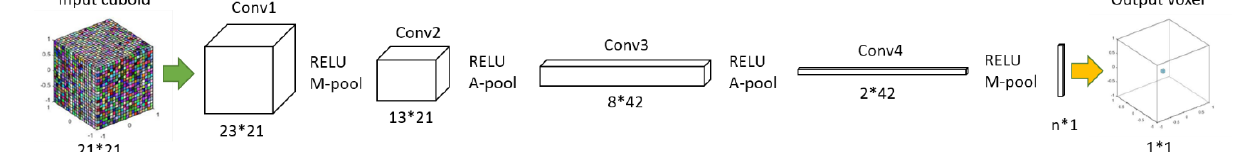
Figure 2. Our Convolutional Neural Network has four main blocs, each having their respective convolution-pooling and activation layers. Input cube is fed into the network and the result of the soft-max layer is assigned to the centre voxel. n is the variable for the number of